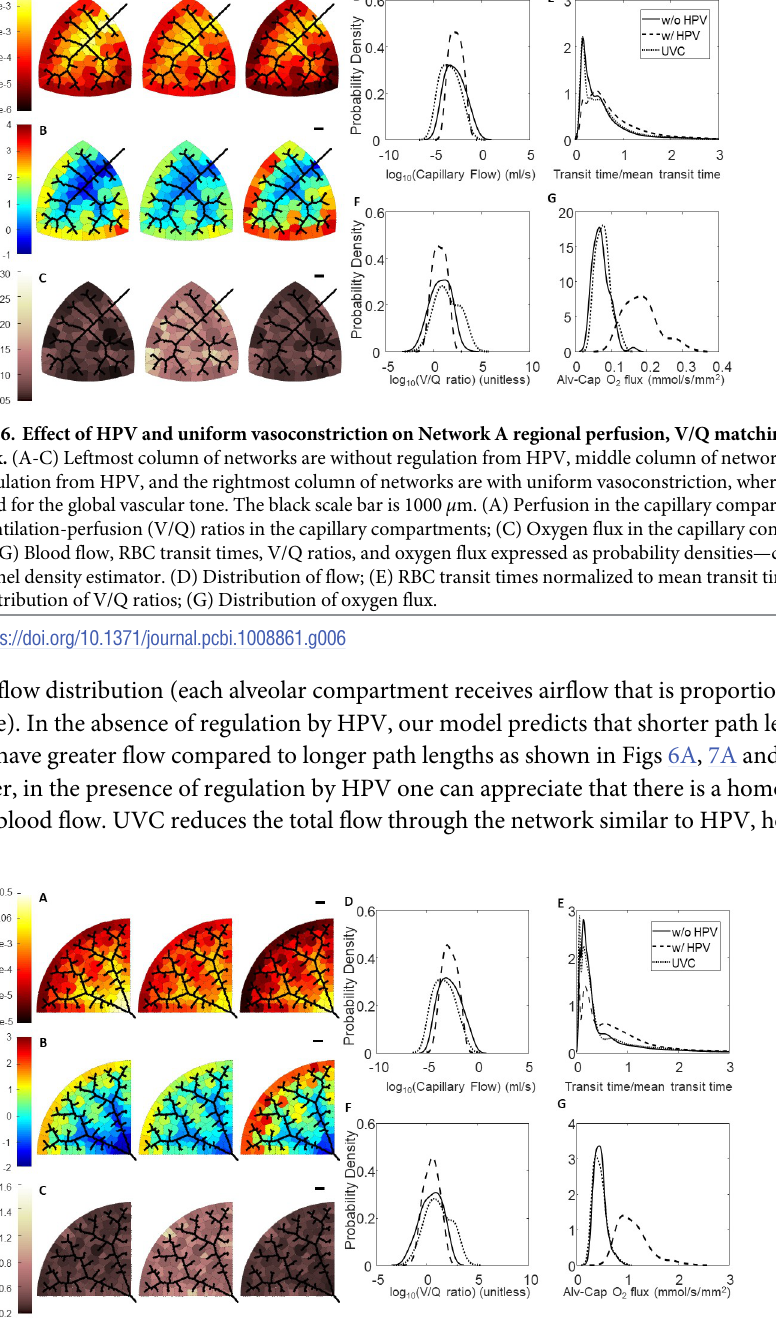
Fig 7. Effect of HPV and uniform vasoconstriction on Network B regional perfusion, V/Q matching, and oxygen flux. (A-C) Leftmost column of networks are without regulation from HPV, middle column of networks are with regulation from HPV, and the rightmost column of networks are with uniform vasoconstriction, where T � = 0.8 is used for the global vascular tone. The black scale bar is 1000 μ m. (A) Perfusion in the capillary compartments; (B) Ventilation-perfusion (V/Q) ratios in the capillary compartments; (C) Oxygen flux in the capillary compartments. (D-G) Blood flow, RBC transit times, V/Q ratios, and oxygen flux expressed as probability densities—calculated with a kernel density estimator. (D) Distribution of flow; (E) RBC transit times normalized to mean transit time; (F) Distribution of V/Q ratios; (G) Distribution of oxygen flux.